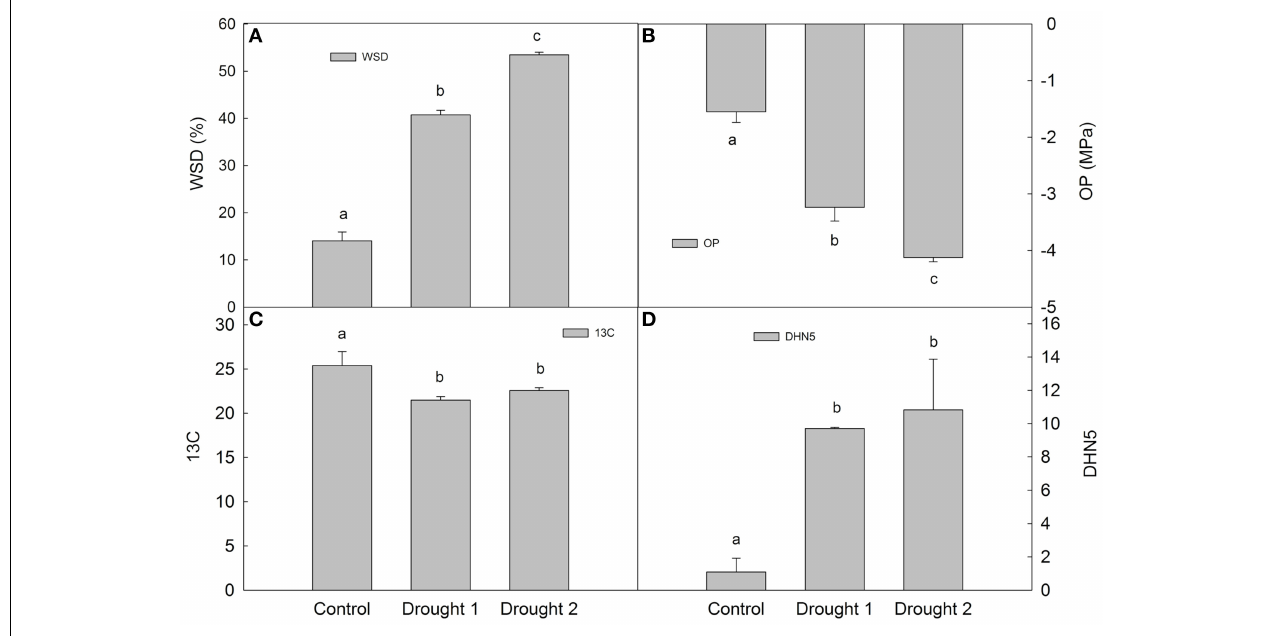
and drought 2 conditions. Error bars indicate standard deviation (SD), different letters indicate significant differences at 0.05 level using Duncan’s multiple range